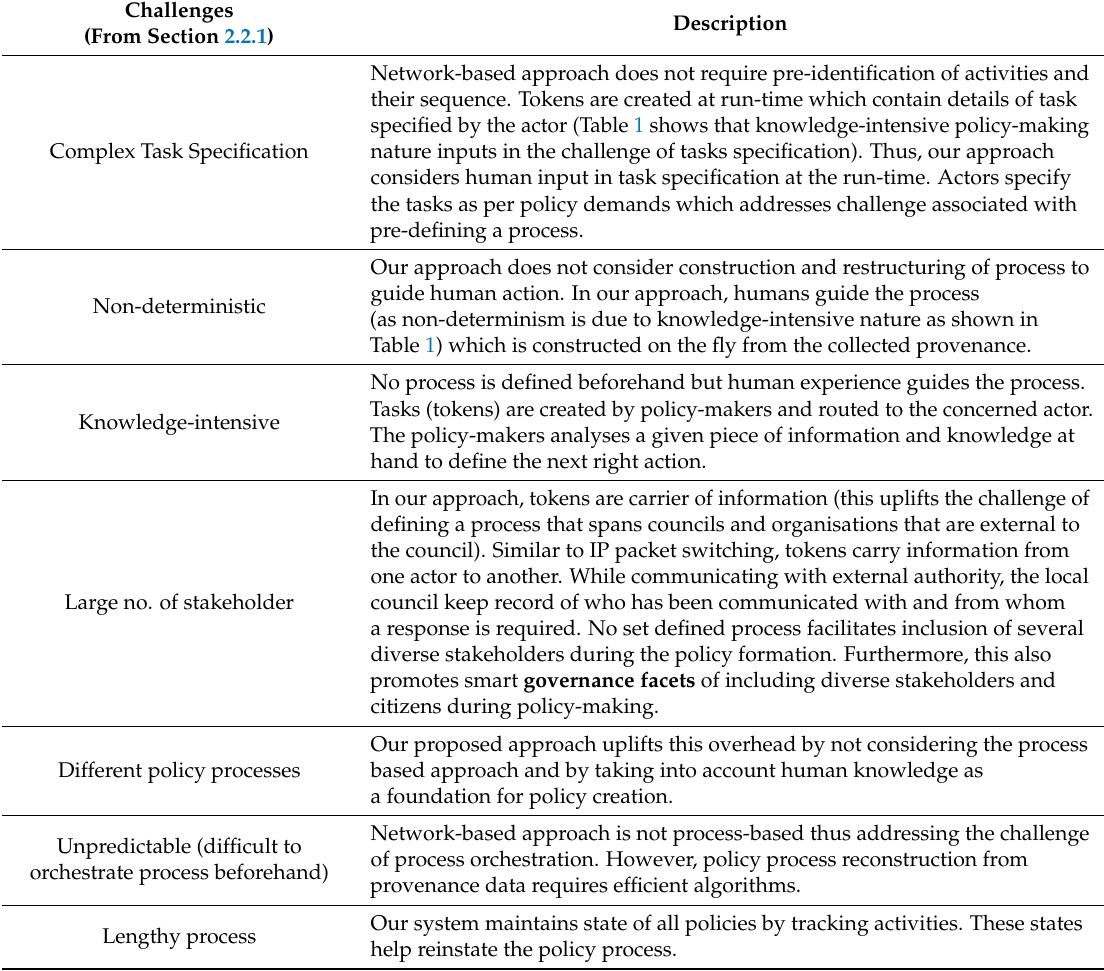
Table 2. Effectiveness of the network-based approach—handling the identified challenges.